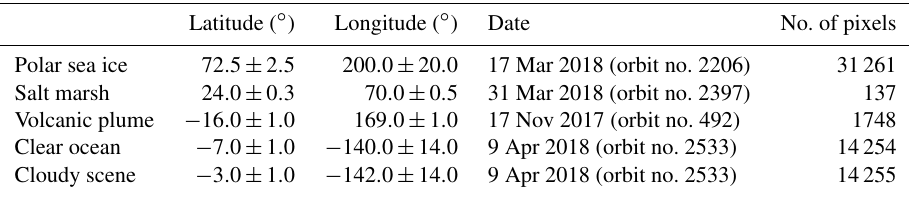
Table 1. Geographical and time information for the different scenarios of the sensitivity tests in Sect.